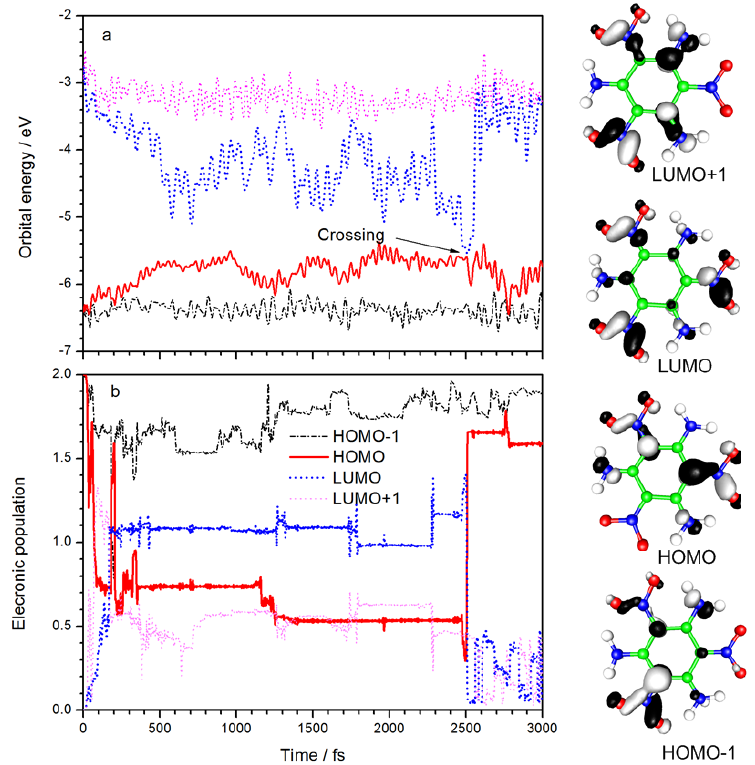
Figure 2. Variations with time of ( a ) the orbital energy and ( b ) electron populations of the HOMO-1, HOMO, LUMO, and LUMO+1 of TATB molecule.